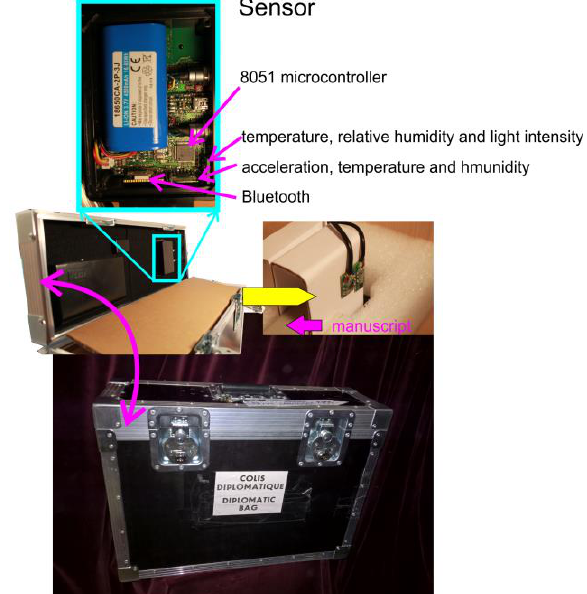
Figure 6. Transport sensor for internal climate monitoring in transport box protecting precious manuscript. In addition to autonomous operation for several months, Bluetooth connection can be used for proper handling care as it allows to eliminate thermal shocks to protected object when the box is open prematurely without adjusting gradually temperature in the box to the temperature in the room.